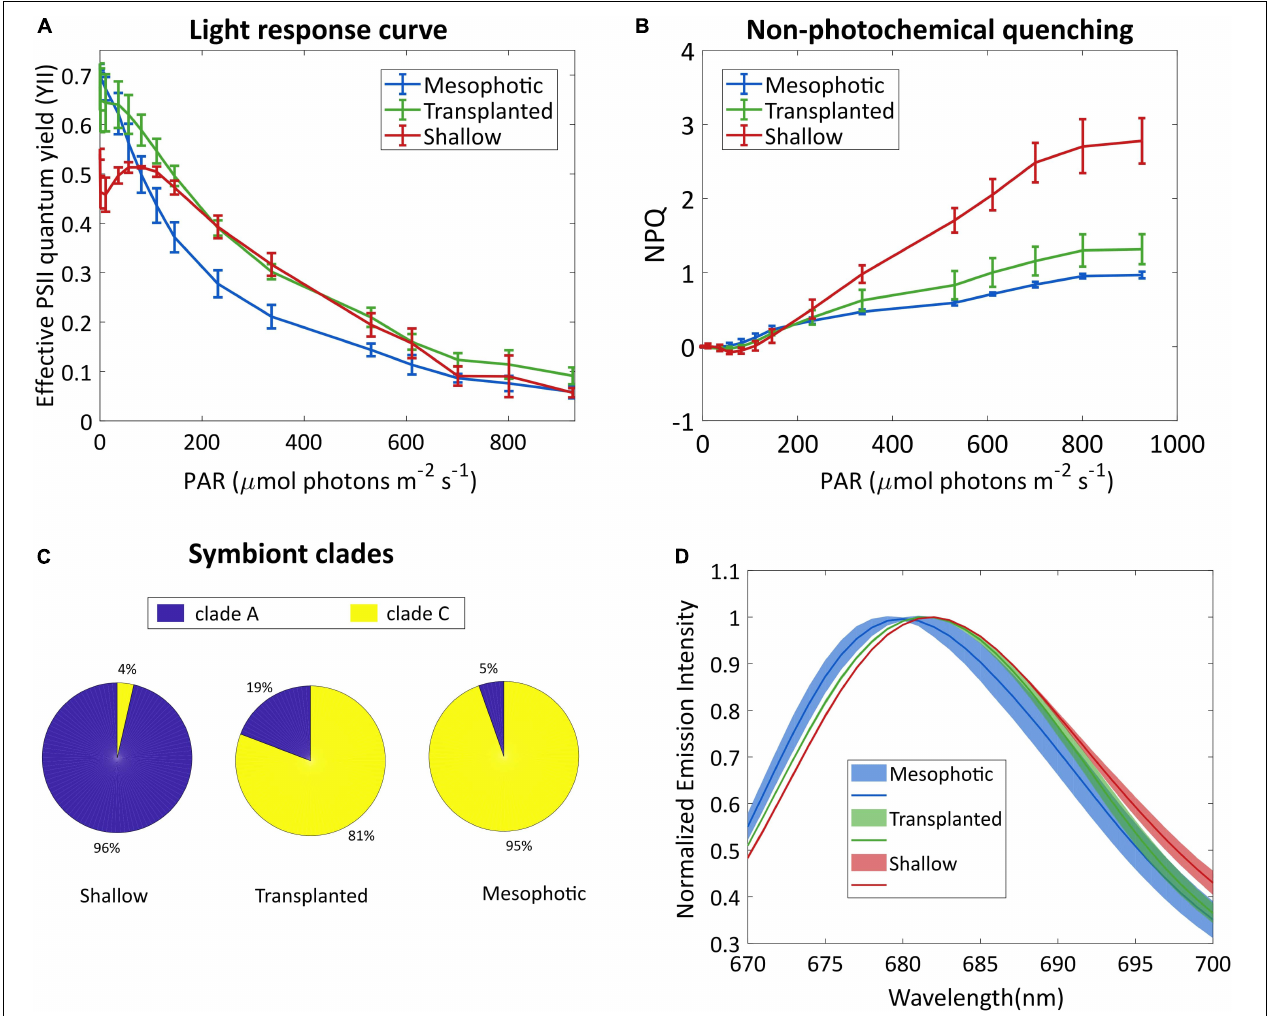
FIGURE 2 | Symbionts analysis. (A) Effective photosystem II quantum yield of the symbionts and (B) non-photochemical quenching, under different irradiances. Error bars show SD of three different fragments. (C) Symbiont clade composition 18 months after the reciprocal transplant. SD values are ± 1, ± 7, and ± 1.7% for the shallow, transplanted and mesophotic groups, respectively. (D) Fluorescence spectra of the symbionts, following excitation at 475 nm. Lines show averaged spectra, the shaded area represents the SD ( n = 3).